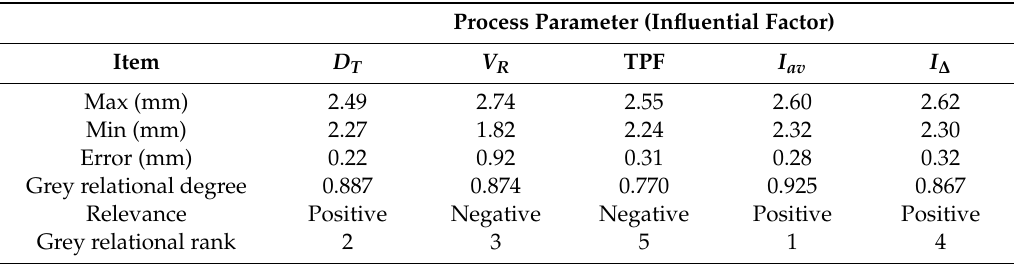
Table 6. Grey relational analysis about the bead height h Table 6 . Grey relational analysis about the bead height h.